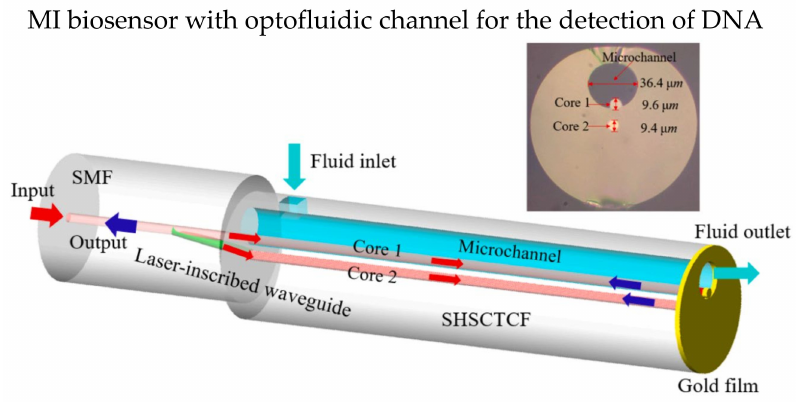
Figure 10. Schematic diagram of optofluidic MI biosensor. One of the cores of the twin-core fiber was exposed to the microchannel as shown in the inset. Reprinted with permission from Ref. [94]. Copyright 2022,